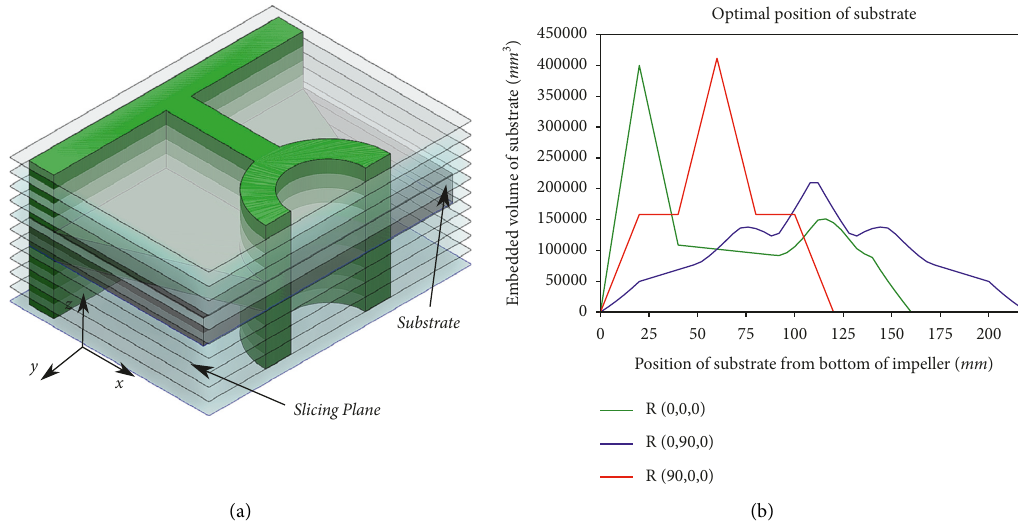
Figure 7: Illustrative example 1: (a) CAD model and (b) VI for different positions of the substrate with different orientations.